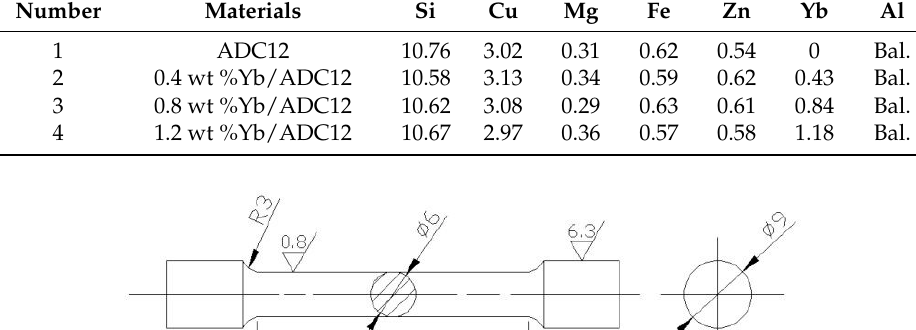
Table 1. Chemical composition of testing samples (mass fraction/wt %).